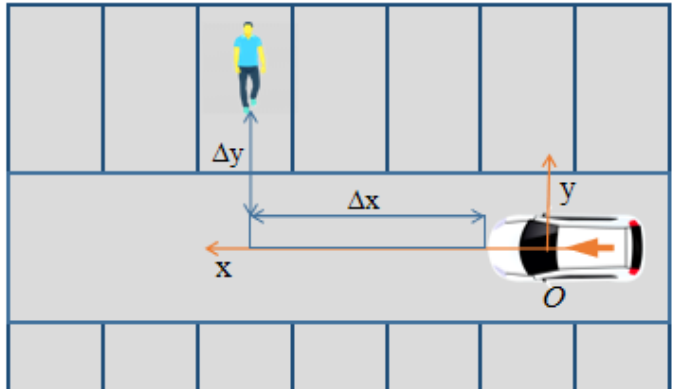
Figure 5. Relative position of pedestrian and vehicle.